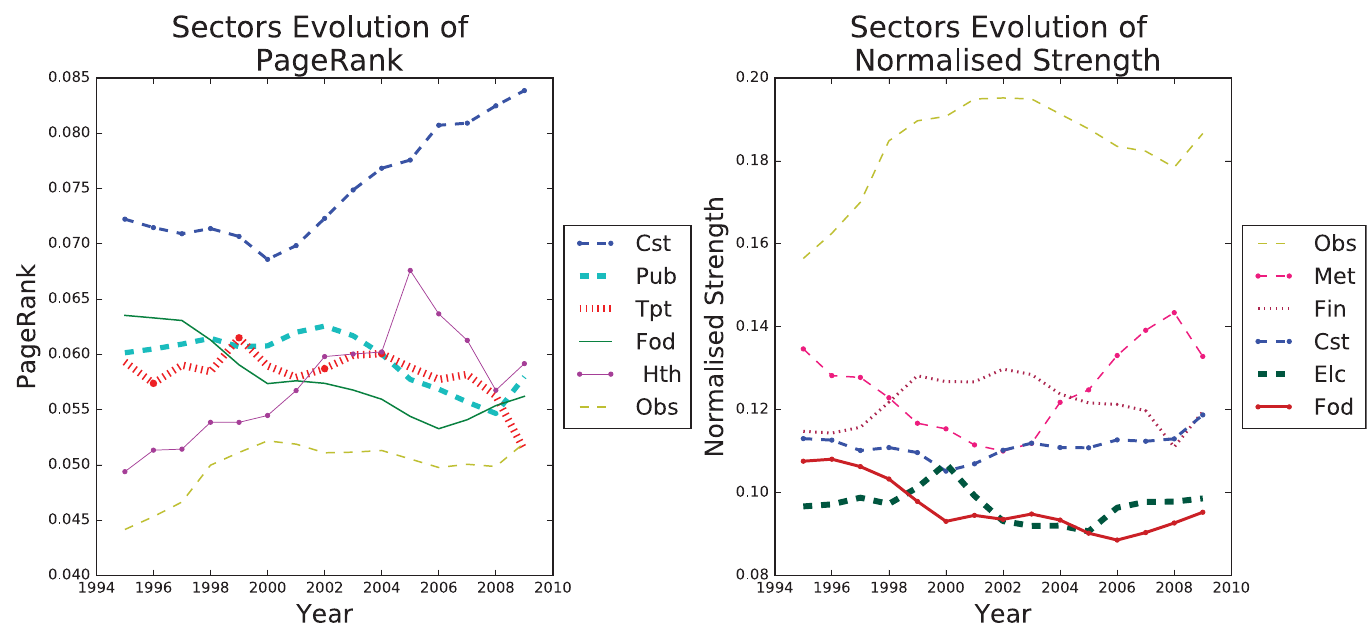
Fig 3. Evolution of sectorsover time. Top 6 rankedsectors by pagerank(left) and strength